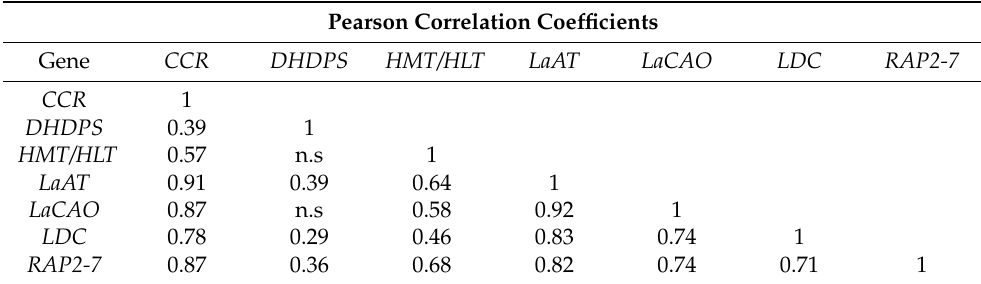
Table 4. Pearson correlation coefficients (significant at p < 0.01; n = 81) between the expression values of alkaloid-related genes, measured for all organs of the bitter narrow-leafed lupin cultivar Oskar using qPCR assay. Full names of genes are listed in Table